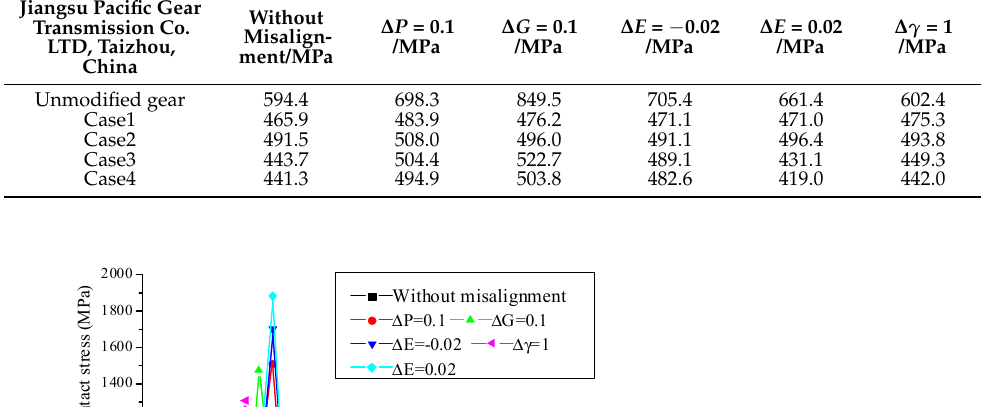
Heel Figure 17. Contact stress distribution for the unmodified driving opinion along tooth width in different installment conditions. Figure 18 shows the contact stress distribution for the tooth end relief gear along the tooth width in different installment conditions. As shown in Figure 18, the contact stress of the tooth end relief gear tooth in different installment conditions is mainly concentrated